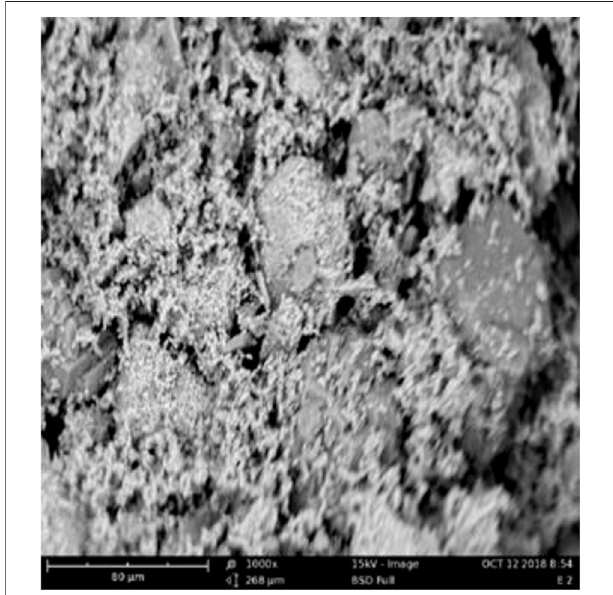
FIGURE 1 | SEM images of FSPD